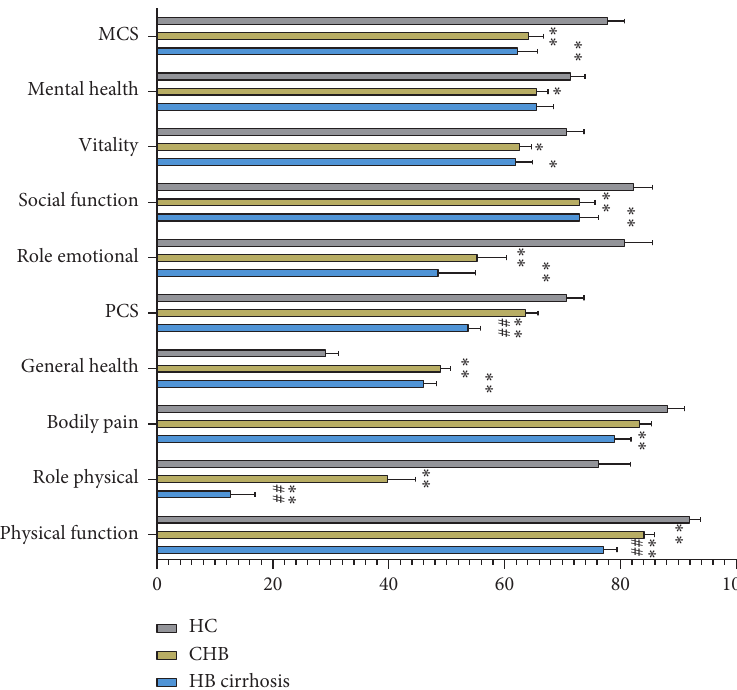
Figure 1: Comparison of SF-36 results across study groups. Note that compared with HCs, the HB cirrhosis group had significantly reduced scores for all dimensions, except for mental health, and the CHB group had significantly reduced scores for all dimensions except for bodily pain and PCS scores. The two HB groups only differed from one another in the role physical and PCS scores. ∗ p < 0 . 05 and ∗∗ p < 0 . 01 vs. HC. # p < 0 . 05 and ## p < 0 . 01 vs. CHB. Table 3: Comparison of EQ-5D dimension score levels and VAS scores between study groups.